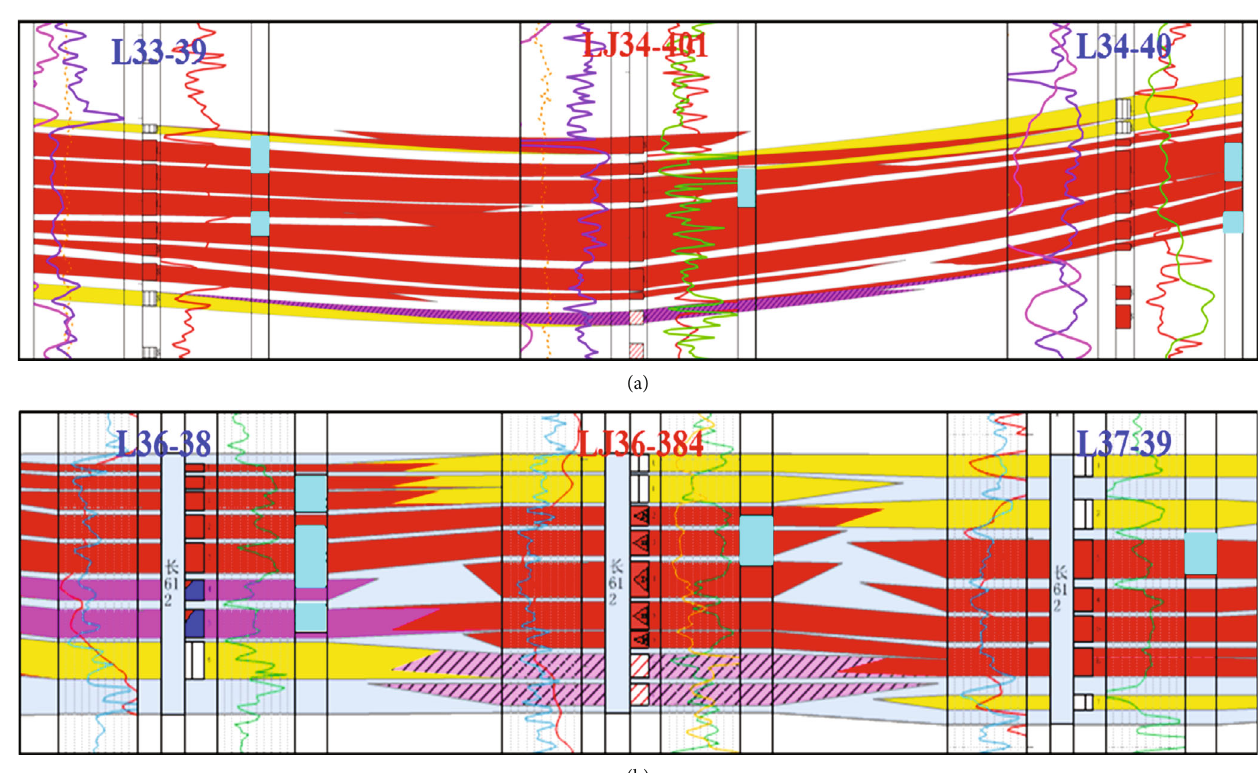
Figure 8: Section of sand body connectivity. (a) Well connected. (b) Moderate